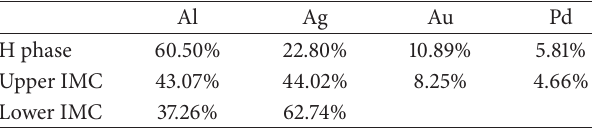
Table 1: EDS of the three layers of IMC